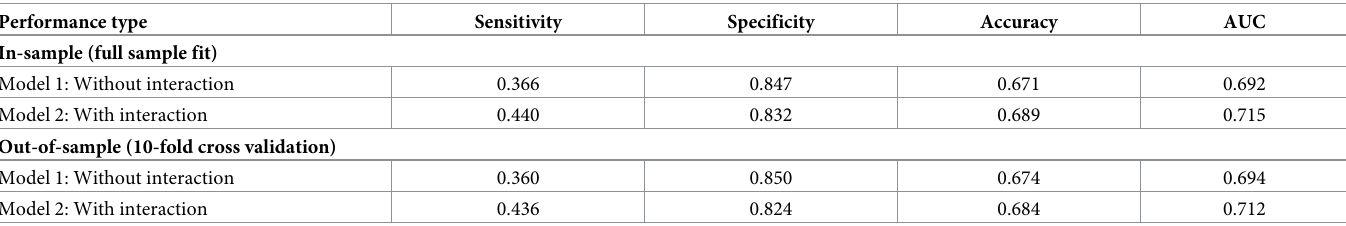
Table 4. Comparison of model